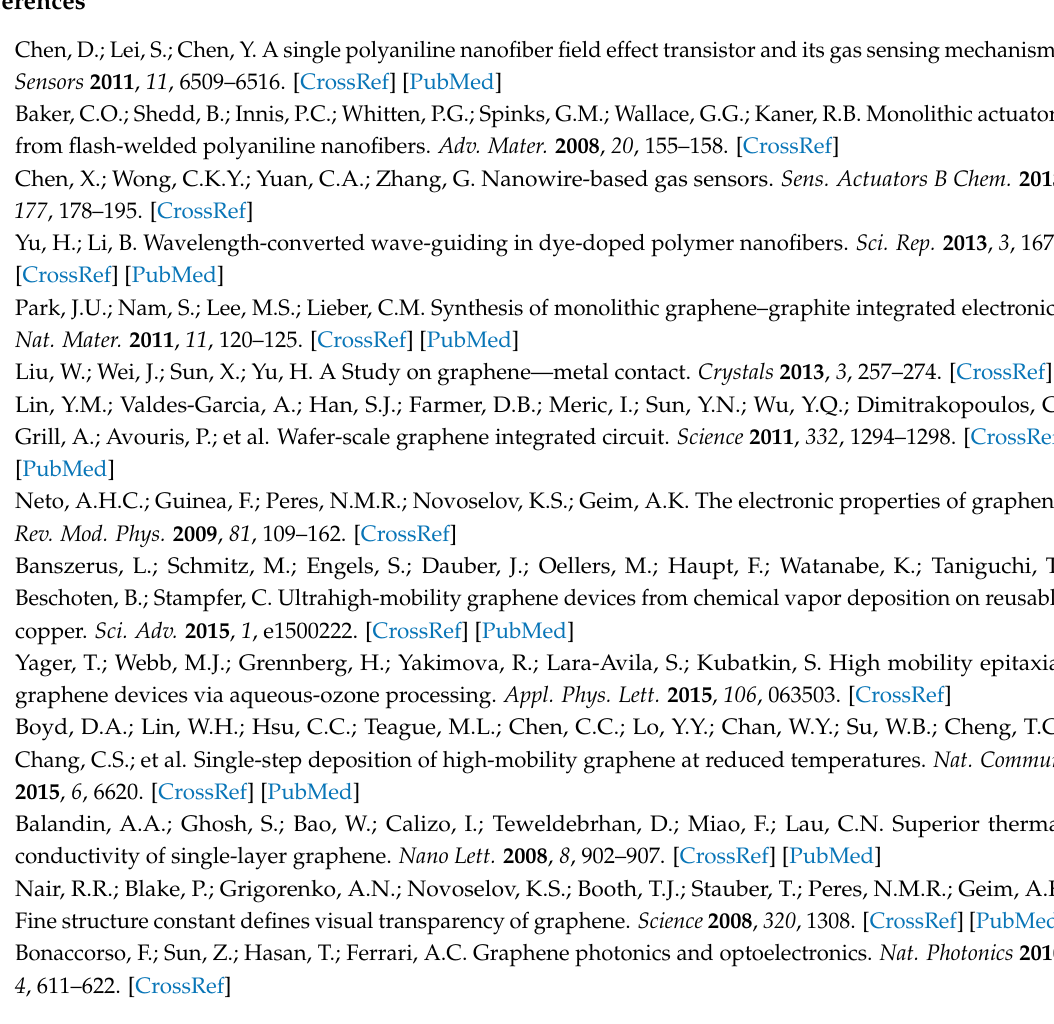
Figure S7: G3 and G4 AFM topography (a) and phase (b) of PANI contacted G/SiC on contact 1-2 (G3), 2-3 (G4), and 3-4. The device shown in Figure 3 is G4 and among the three PANI nanofibers in G4, the nanofiber in Figure 3 is in the middle of the electrode. We checked that the electrodes (1), (2), (3), and (4) were electrically insulating each other before nanofiber deposition. (c) and (d) are the AFM topography and phase after T = 800 ◦ C annealing, respectively; (e) Current-Voltage characteristics of the PANI nanofiber contacted between contacts 1-2 (G3), 2-3 (G4), and 3-4 before T = 800 ◦ C annealing. (f) Current-Voltage characteristics of the PANI nanofiber Table S1: Summary of PANI-Au devices (Au1–Au6) in height, source-drain distance, and conductivity; Table S2: Summary of PANI-G/SiC devices (G1–G6) in height, source-drain distance and